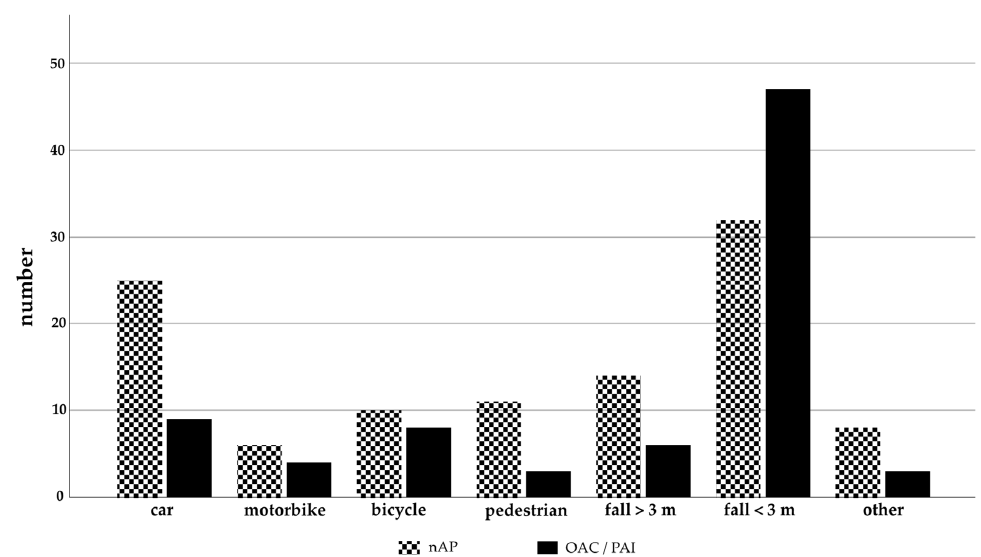
Figure 1. Trauma mechanism in patients with and without oral anticoagulation (OAC)/platelet aggregation inhibitors (PAI).